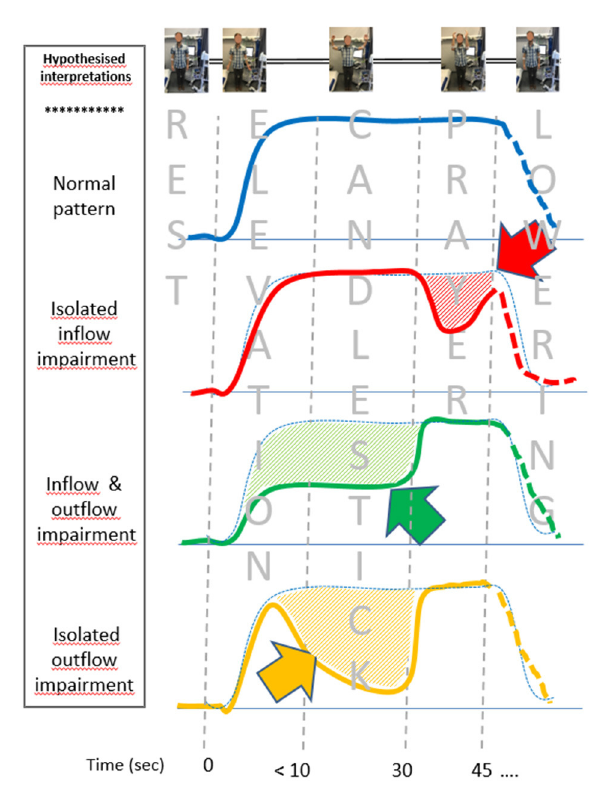
FIGURE 5 | Schematic representations of the venous photo-plethysmography pattern interpretation, depending on the presence of inflow and/or outflow impairment (emptying is an upward change, while filling is a downward change). Differences from the assumed normal pattern (blue dot points) are underlined by hash bars and arrows. Isolated inflow impairment during the candlestick phase is assumed to result in post-ischemic vasodilation. The green figure is expected to result from arrested inflow and outflow during the candlestick that are normalized during the prayer position. Outflow impairment with persistent inflow results in forearm filling, followed by emptying at the prayer position (yellow figure). The lowering was not standardized and might be different in each pattern and thus presented as dash